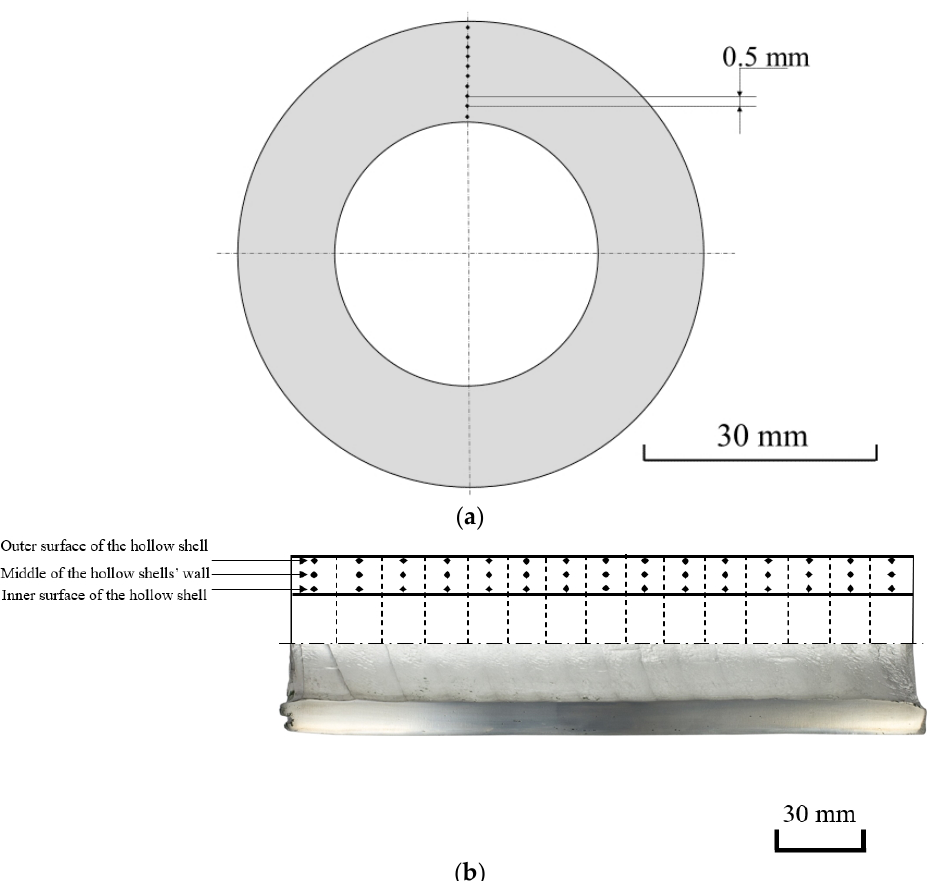
Figure 4. Microhardness measurement scheme in the cross-section at the stationary stage of piercing ( a ) and the longitudinal section ( b ) of the hollow shell.